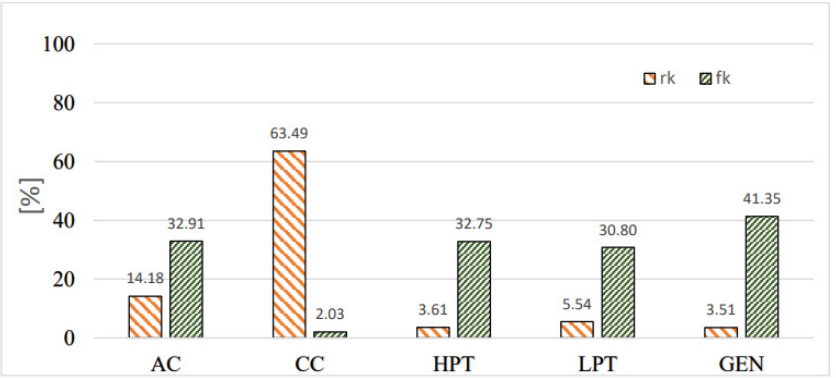
Figure 4. Exergoeconomic factor ( 𝑓𝑘 ) and relative difference in cost ( 𝑟𝑘 ) for main components of the gas- turbine engine (axial compressor).